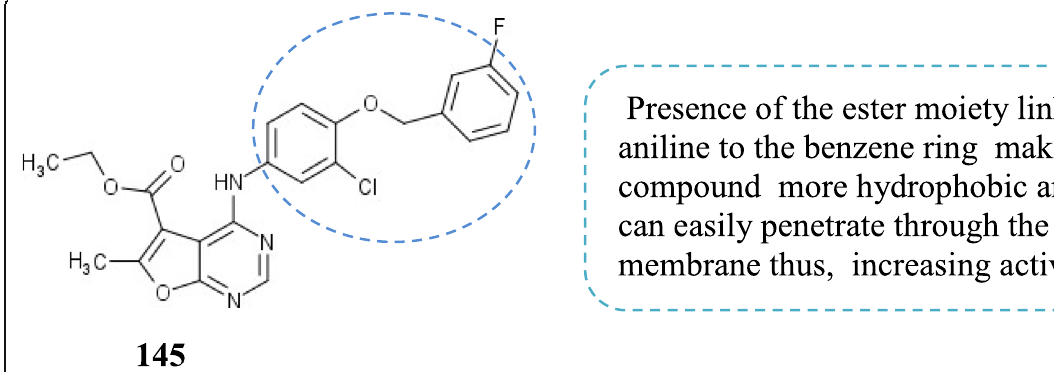
Fig. 43 SAR and chemical structure of novel anilino pyrimidine